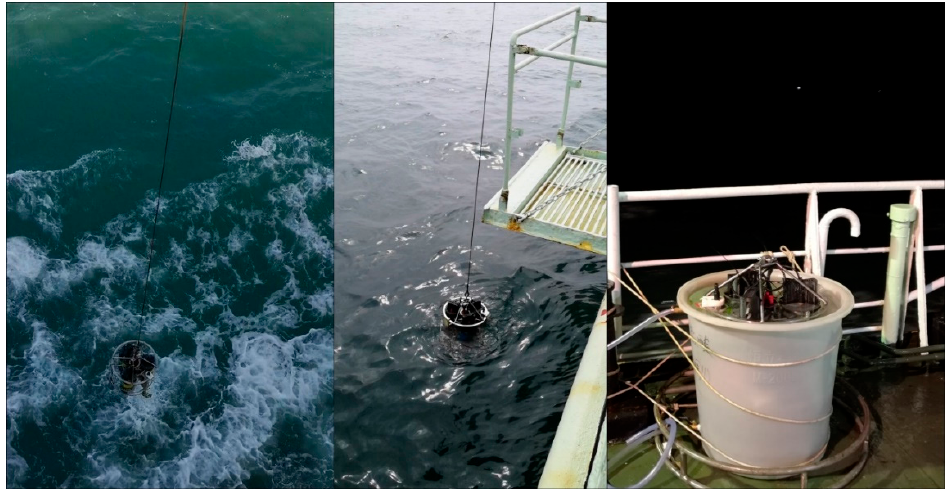
Figure 5. Photos of the analyzer being pulled out of seawater during in situ experiments on SHIYAN 1 ( left ) and SHIYAN 2 ( middle ); photo of online experiment ( right ).